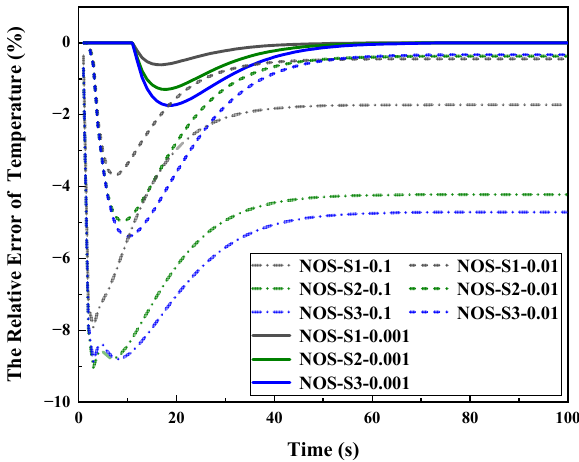
Figure 9. The relative error of the average temperature of the three rectangular block surfaces of the novel optimization strategy with different criteria relative to the traditional coupling algorithm. Table 1. Computational time-consuming comparison of three different algorithms.